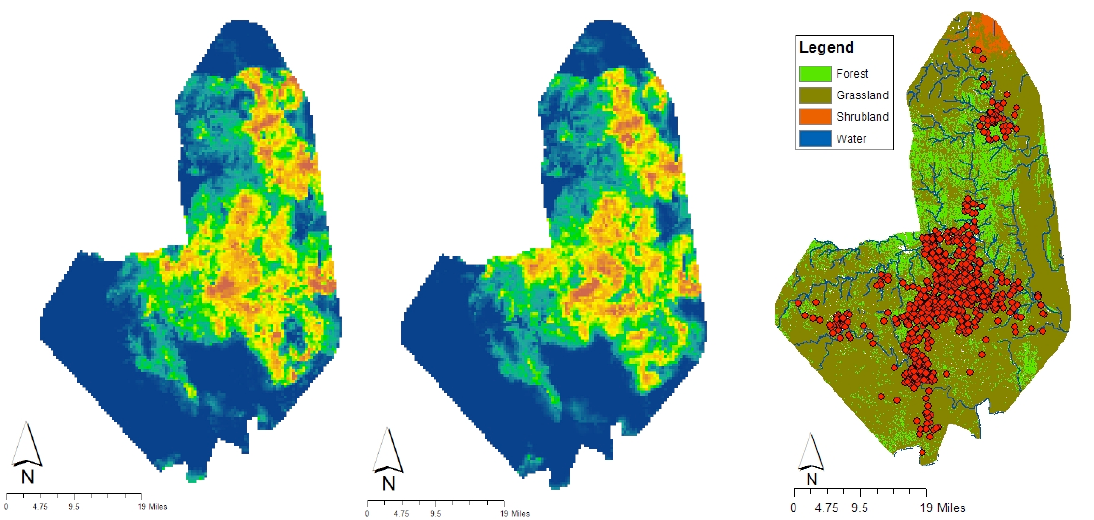
Figure 2. Prediction maps from MaxEnt showing probability of elephant occurrence within the study area based on the Globeland30 (left) and Globcover (center) based on GPS collar training data, a subset of which is shown over Globeland30 classification scheme (right).